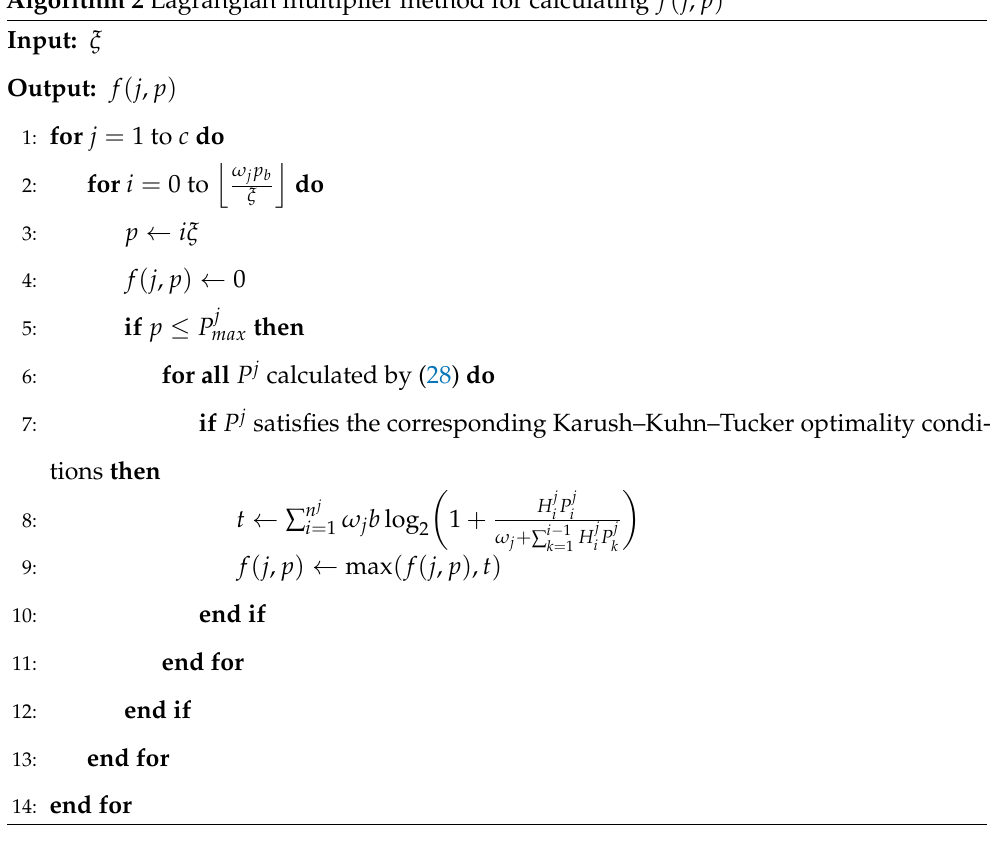
Algorithm 2 Lagrangian multiplier method for calculating f ( j , p